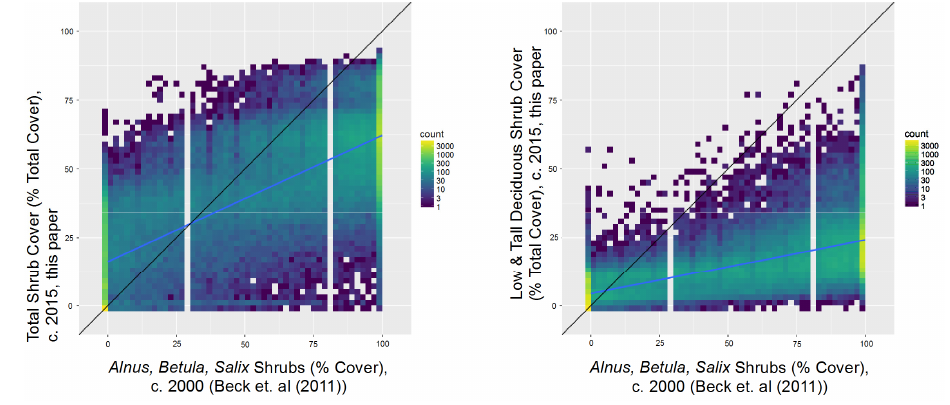
Figure 12. Comparison of shrub cover from Beck et al. [29] circa 2000 North Slope shrub map and the current work, North Slope, Alaska. The black line is 1:1 line, and the blue line is the linear best